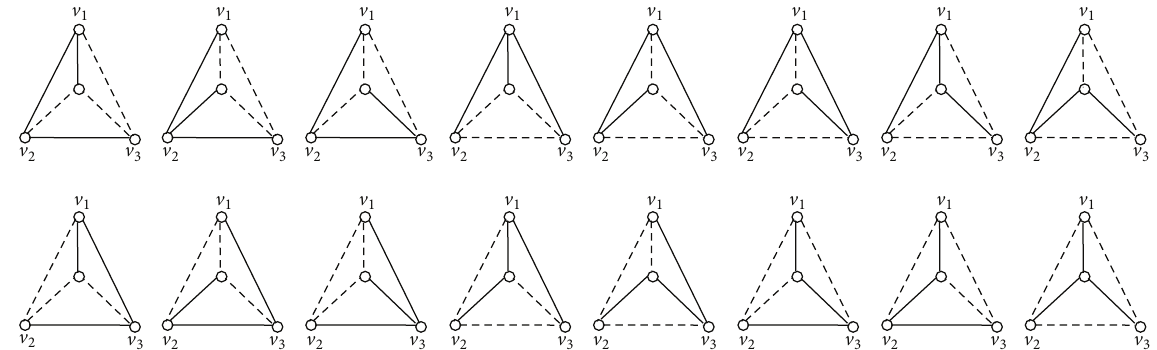
Figure 3: The number of spanning trees of 𝑀(1) is 16 . The solid link indicates that one node is connected to another node; the dashed link indicates that one node is not connected to another node.